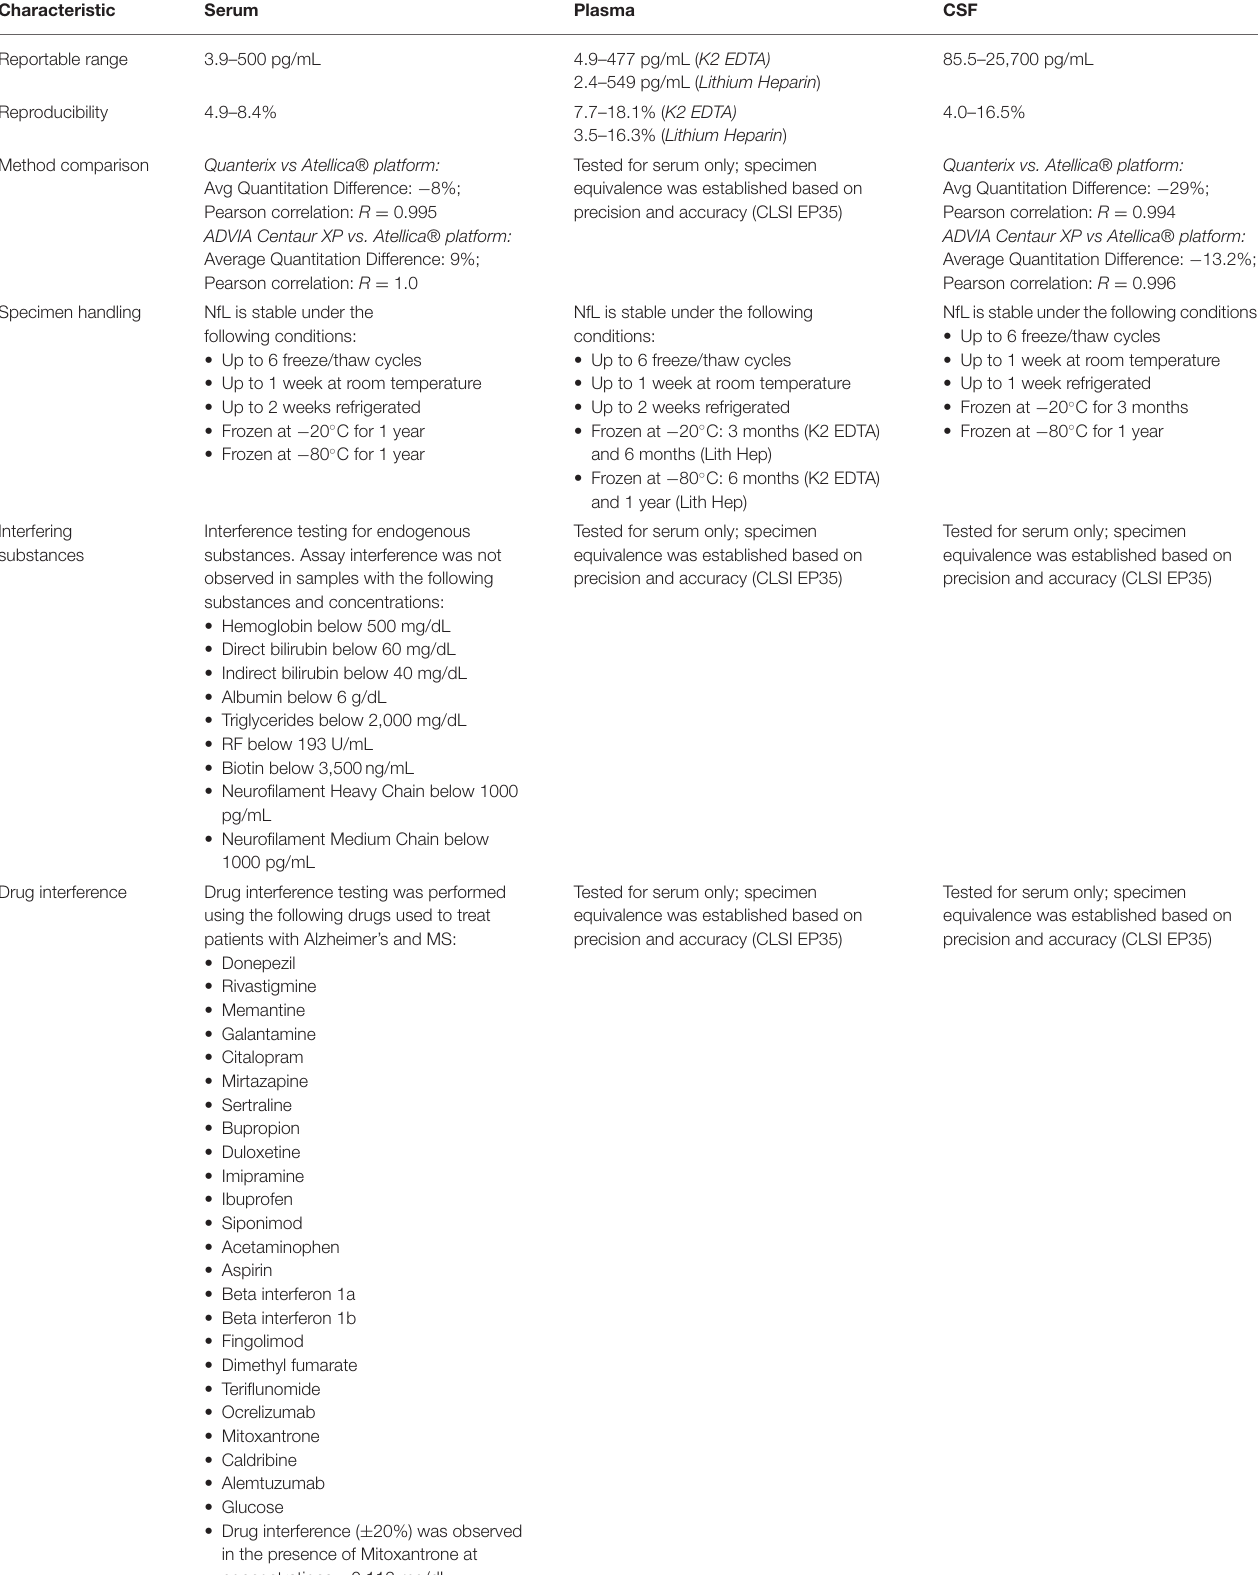
TABLE 6 | Summary of analytical validation of the LDT version of the NfL assay. Characteristic